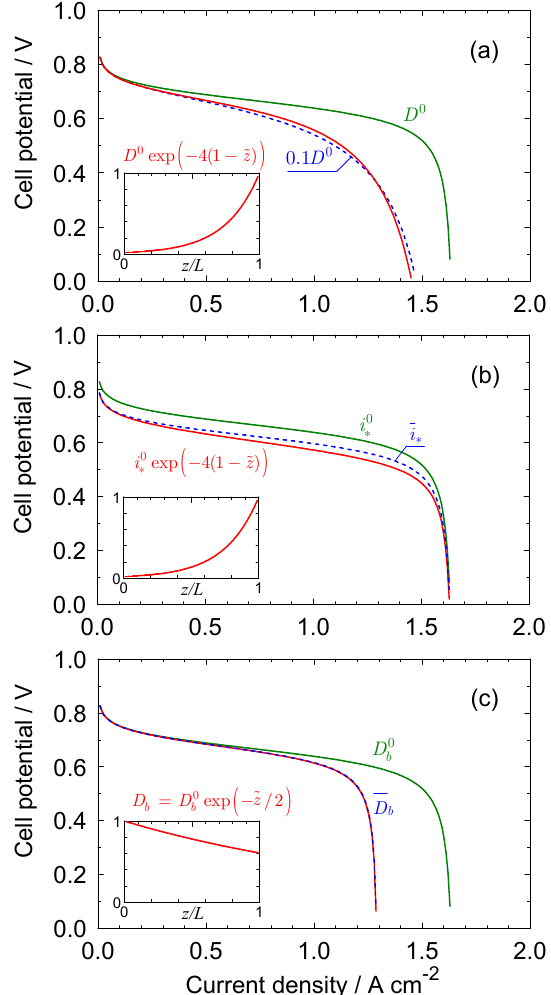
Figure 2. Pristine (solid black line) and “aged” polarization curves. Solid red lines correspond to non-uniform aging of: ( a ) CCL oxygen diffusivity; ( b ) exchange current density and ( c ) GDL oxygen diffusivity. Dashed lines exhibit the polarization curves for the uniform along the channel aging of the respective parameter. Insets: the ˜ z -shapes of “aged” parameters used in the